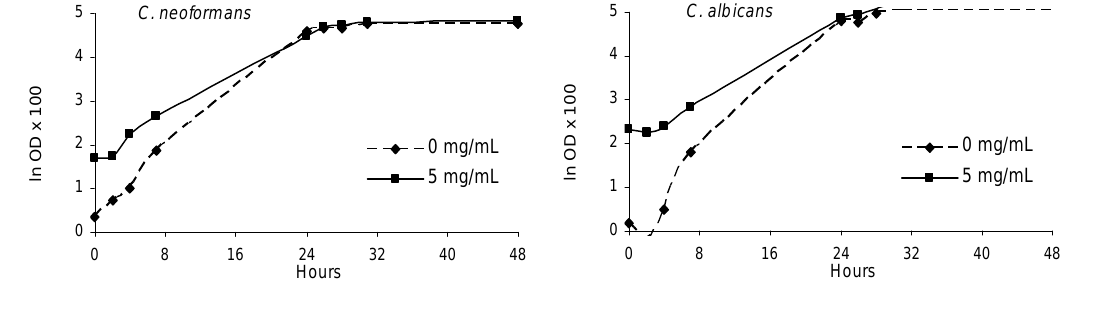
Figure 4. Fungal growth in the presence of olive leaves extract (5 mg/mL) and in the absence of extract (0 mg/mL) along the incubation period (48